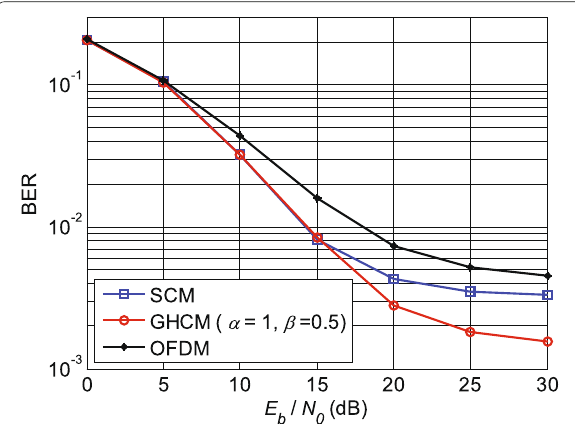
Fig. 5 The performance comparison of GHCM, SCM, and OFDM